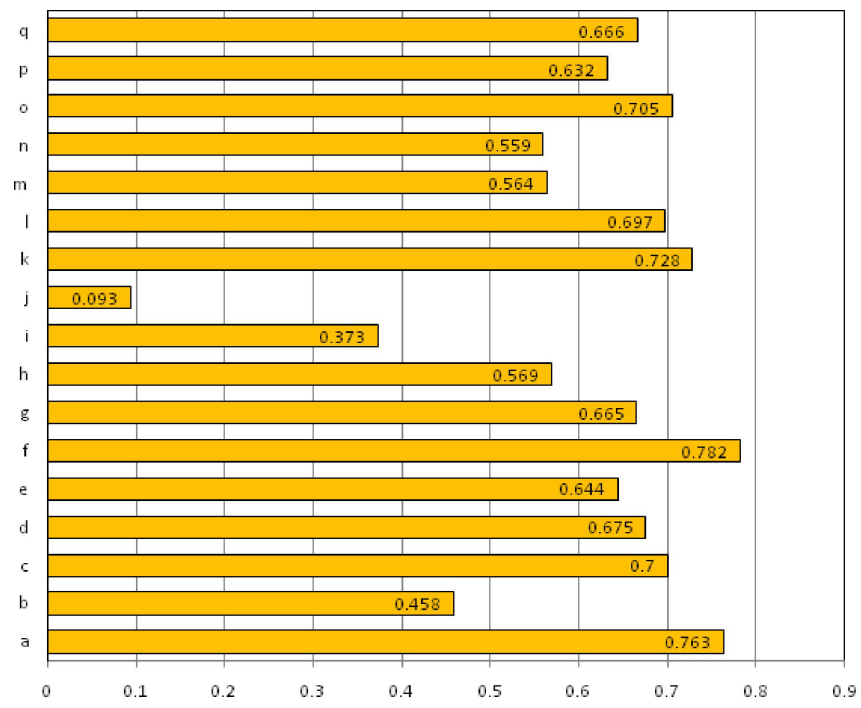
Figure 1. Impact of various measures of resource